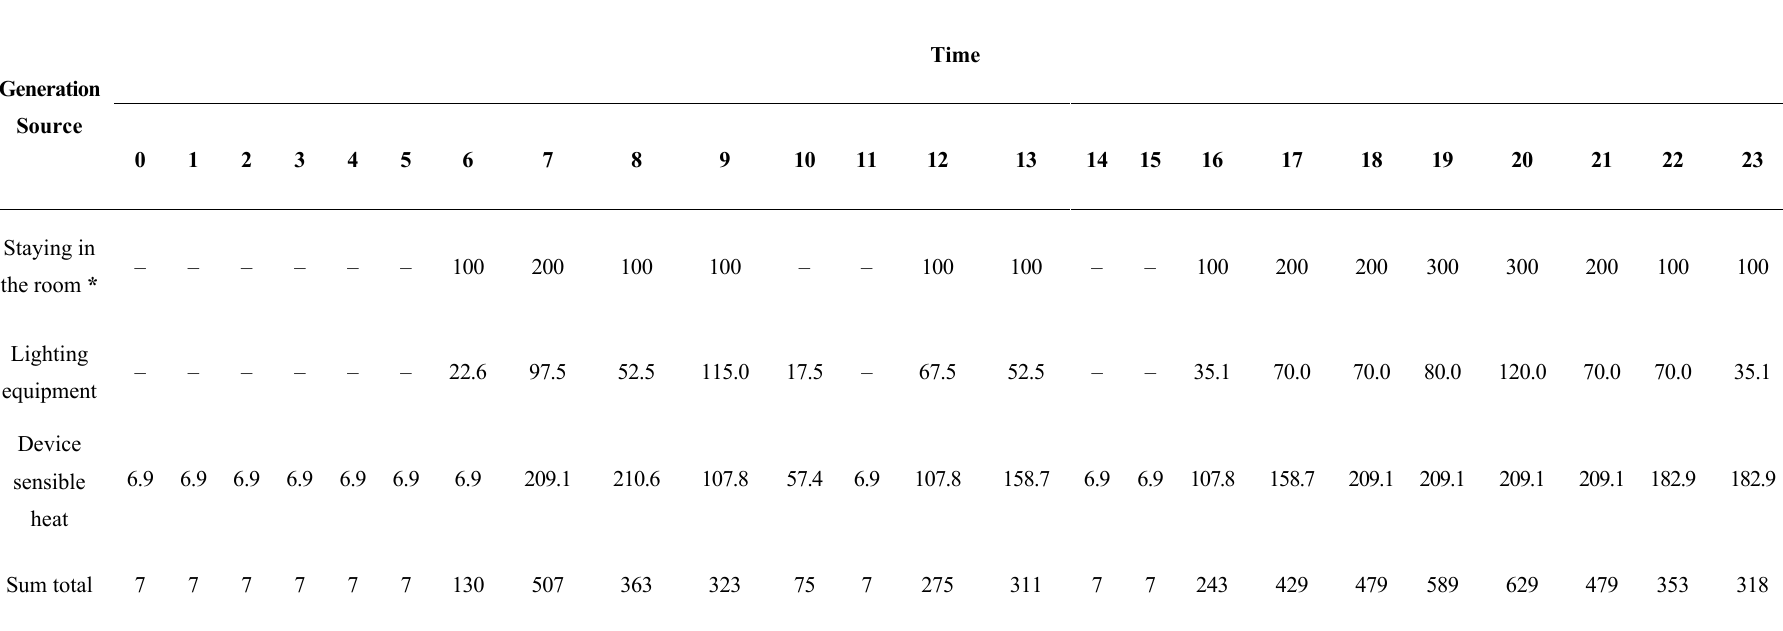
Table A3. Schedule of internal heat generation (Unit: